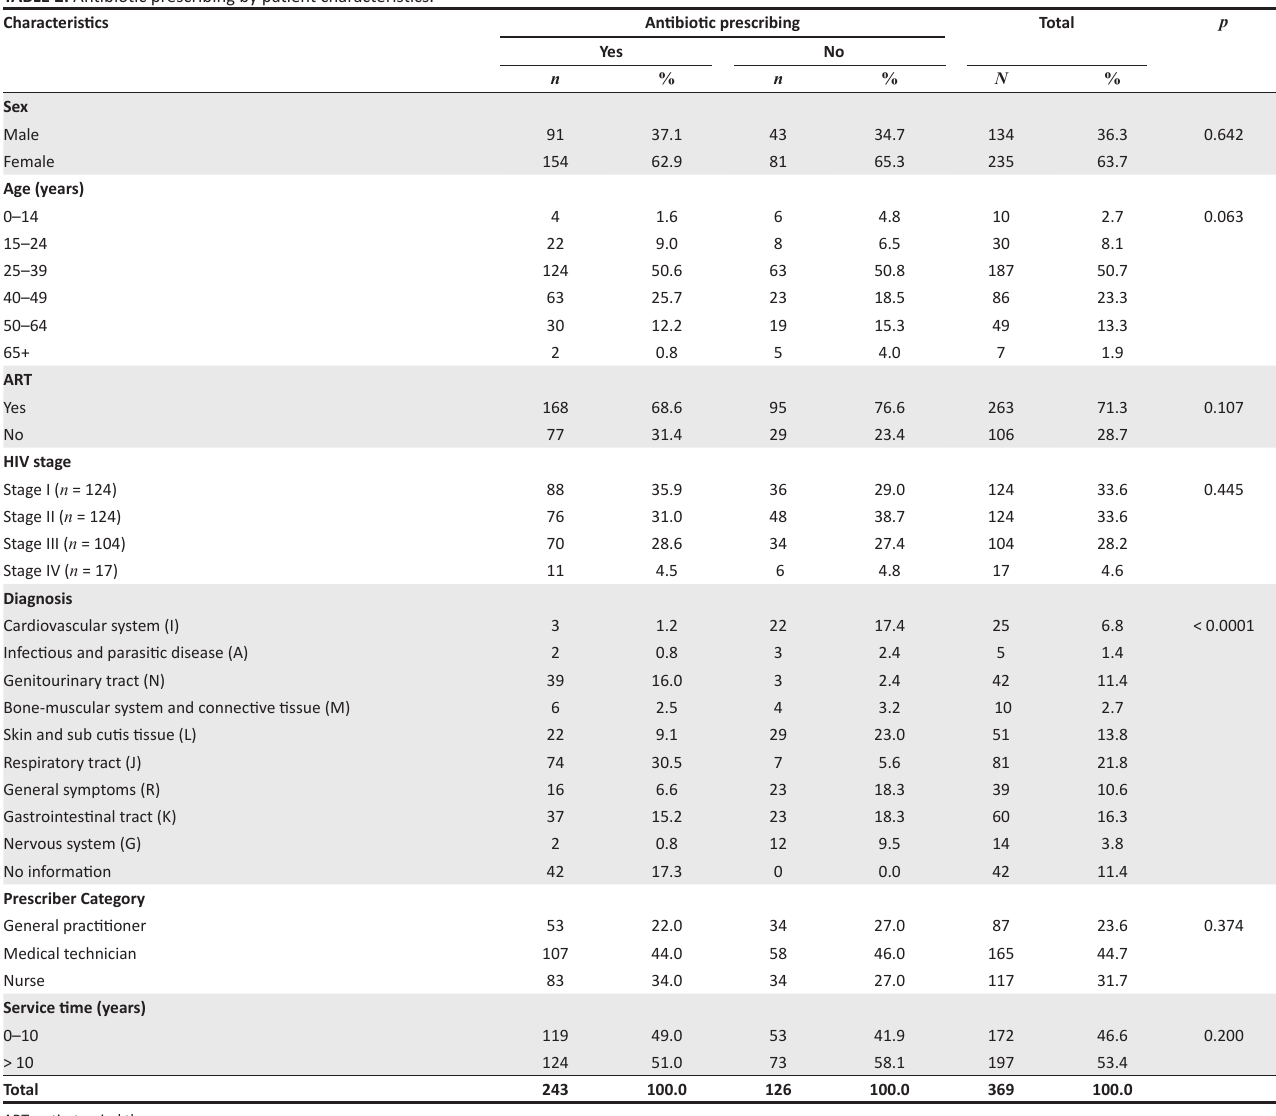
TABLE 2: Antibiotic prescribing by patient characteristics. Characteristics